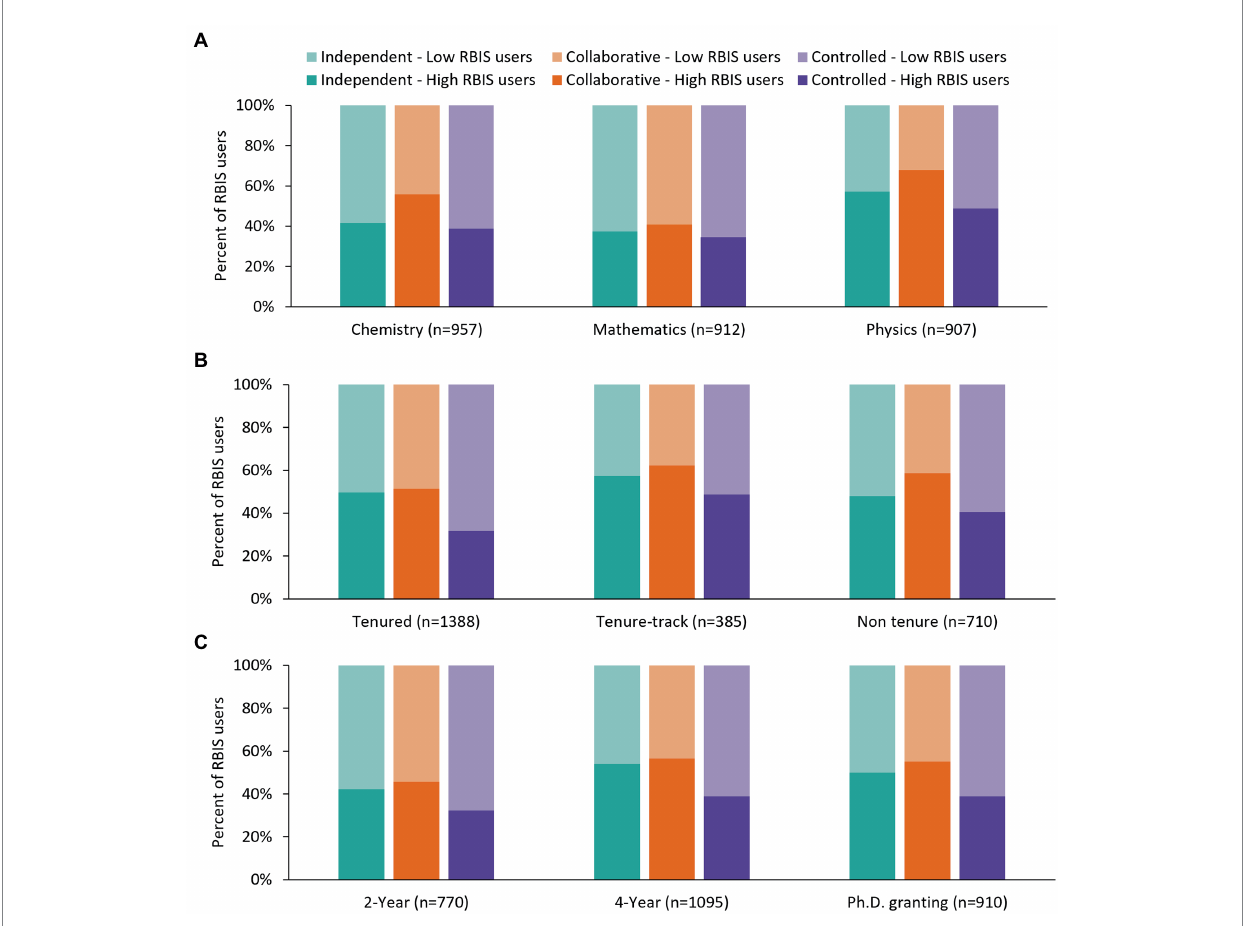
FIGURE 5 Prevalence of RBIS users by coordination type by (A) discipline, (B) appointment, and (C) institution type. See Supplementary Table 1 for statistical